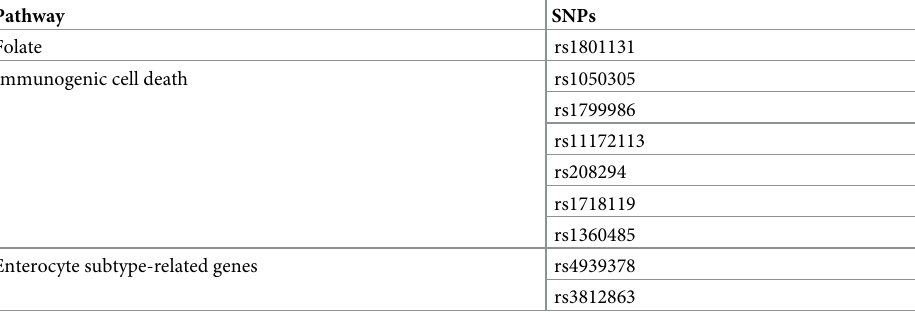
Table 3. SNPs considered in the DACHS case